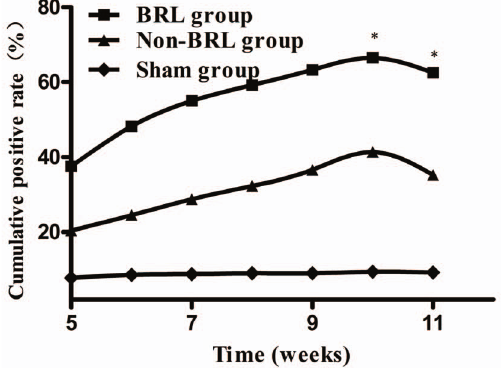
Figure 1. The frequencies of anti- b 3 -autoantibodies in non-BRL and BRL groups of aged rats with heart failure. 2 mL of blood samples were collected before treatment, and at the 5 th , 6 th ,7 th , 8 th ,9 th , 10 th and 11 th week after treatment. The sera were separated by centrifugation (3000 rpm, Beckman CS-15R Centrifuge) for 10 min and stored at 2 80 u C until needed for assay. Anti- b 3 -AR autoantibody was determined by enzyme-linked immunosorbent assays (ELISA). The frequencies of anti- b 3 -autoantibodies in the BRL group increased markedly at the 5 th week, and reached a maximum at the 10 th week in both BRL group and non-BRL group. The frequencies of anti- b 3 - autoantibodies were significantly higher in BRL group than non-BRL group and Sham group (* p , 0.05). BRL group: HF group with b 3 -AR agonist of BRL37344 injection; non-BRL group: HF group without BRL37344